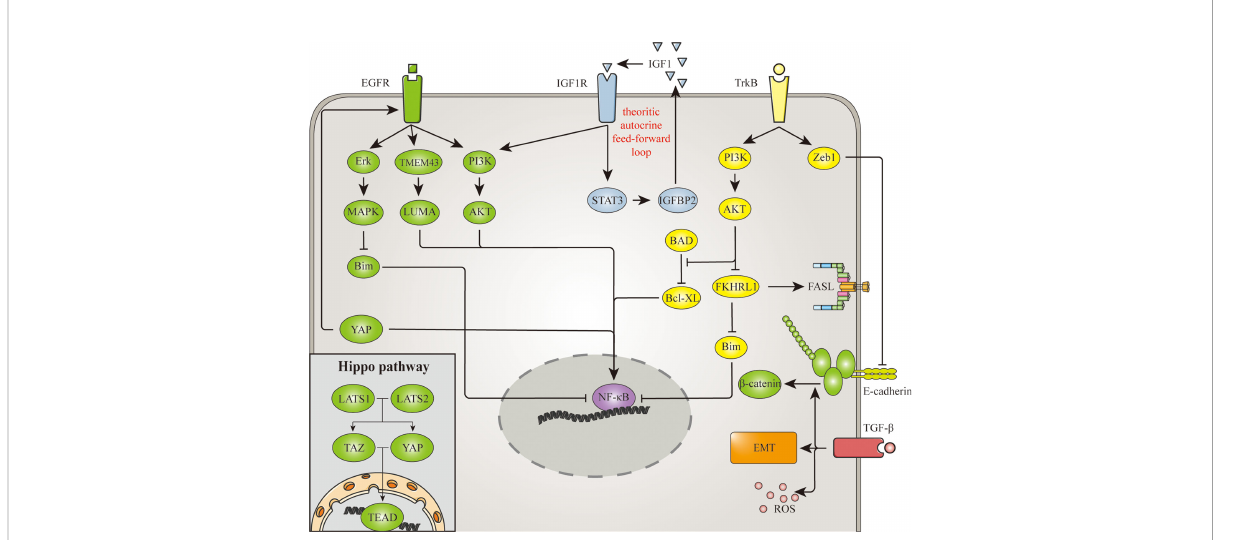
FIGURE 2 Signaling involved in anoikis resistance mechanism of glioma. EGFR, IGFR, TrkB, TGF- b and the hippo pathway are signaling pathways involved in the anoikis resistance of glioma. NF- k B is a common mediator in these pathways, for it regulates the expression of several anoikis-related proteins. Similarly, the hippo pathway promotes anoikis resistance through its transcription factor TAZ. Apart from transcription factors, EGFR also represses Bim expression through Erk/MAPK pathway. Meanwhile TrkB upregulates Bcl-xl and downregulates FasL and Bim through PI3K/ AKT pathway. The signaling of TrkB and TGF- b triggers EMT as well, which promotes cell detachment and anoikis resistance. And there are also EGFR signaling triggered by the hippo pathway, and b -catenin promoted by TGF- b , indicating the connection between adhesion molecules and signaling pathways goes both